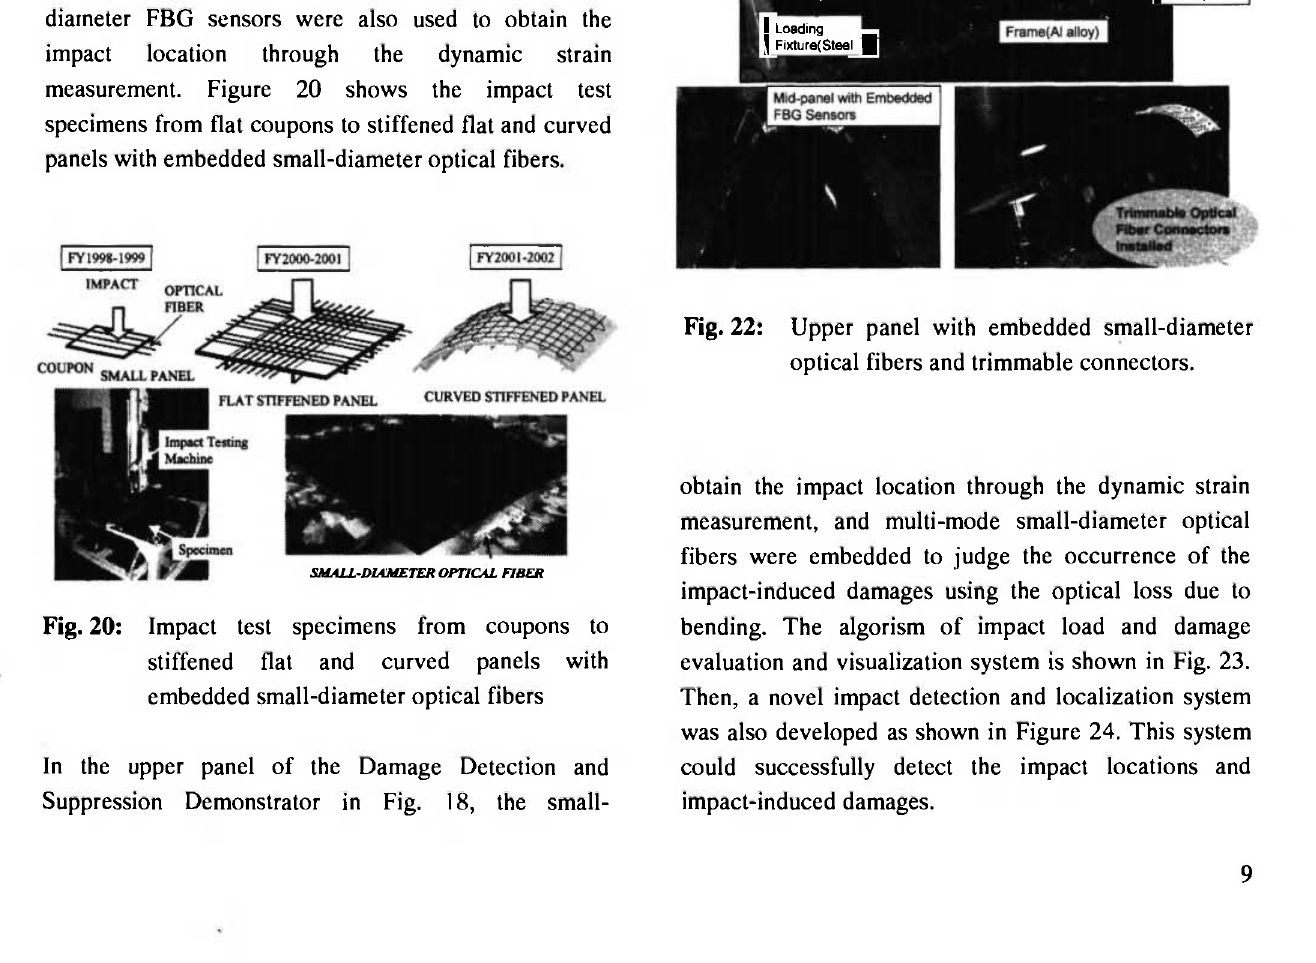
OUTSIDE VIEW INSIDE VIEW Fig.21: Schematic of arrangement of embedded small- diameter optical fibers in the upper panel.